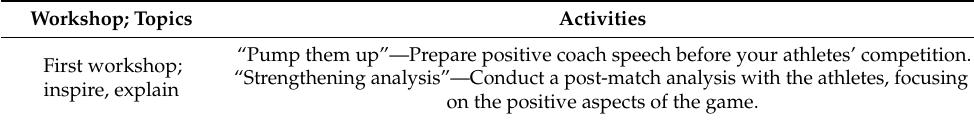
Table 1. Workshop topics (selected dimensions from i7W concept) and examples of the tools and activities introduced during the